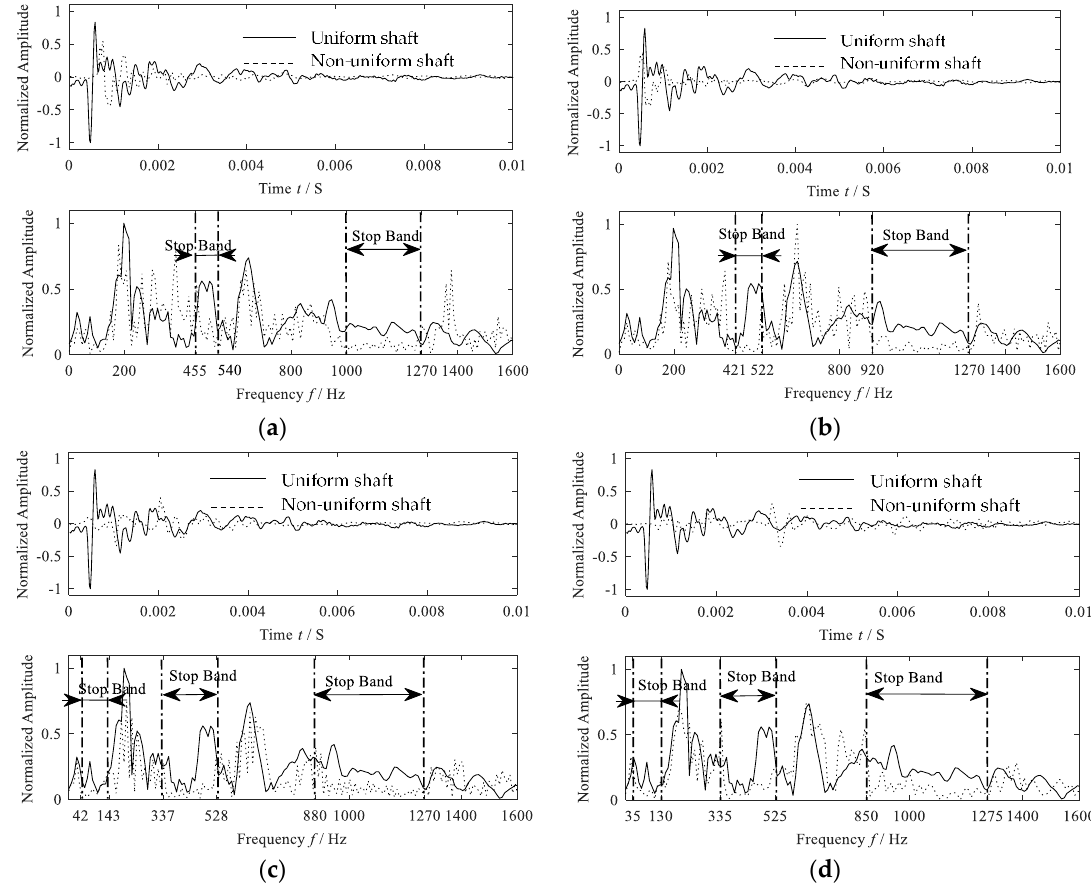
Figure 11. Experimental stopbands derived from different crack depth, where ( a ) is for the case a / R c = 0.1, ( b ) is for the case a / R c = 0.2, ( c ) is for the case a / R c = 0.3 and ( d ) is for the case a / R c = 0.4.